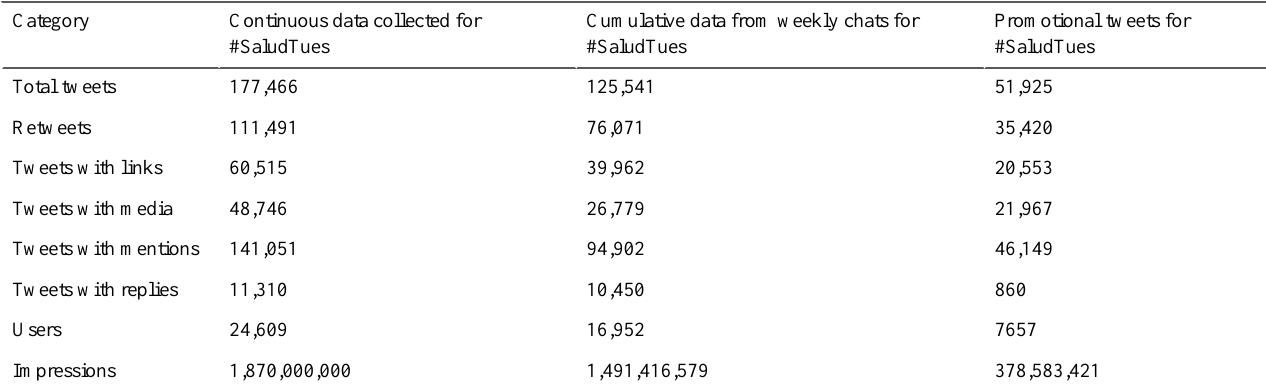
Table 1. Tweetchat metrics on tweets, users, and impressions collected via Symplur 2014-2018.